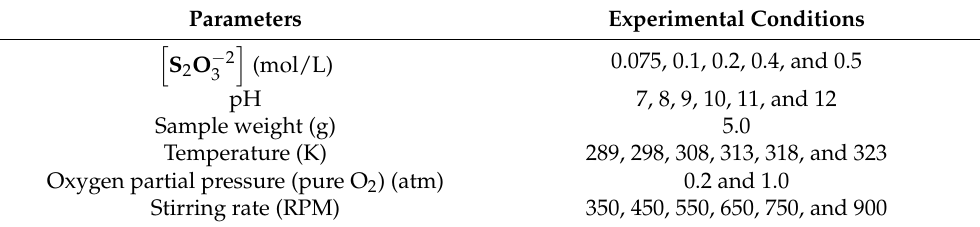
Table 2. Experimental conditions used for the study of copper